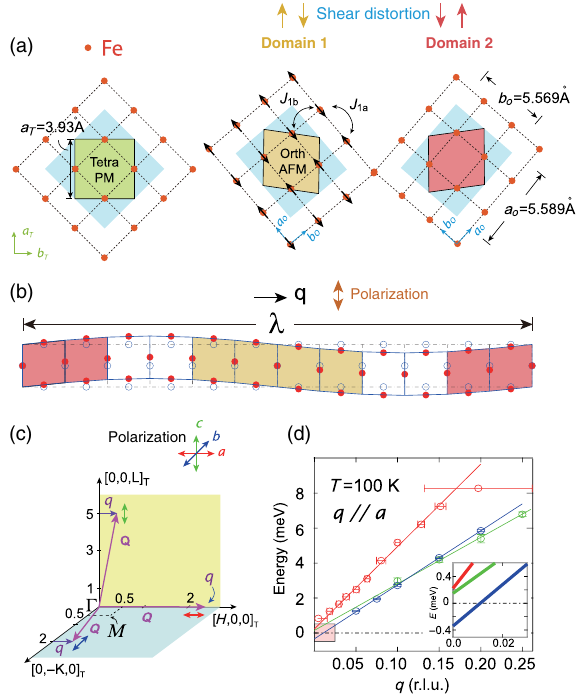
FIG. 1. (a) Left: Schematics of the Fe layers in NaFeAs. Red spots represent Fe atoms, and the tetragonal (orthorhombic) unit cell is shown by the green (blue) shaded square. The middle and right panels are the two orthorhombic domains. The yellow and red areas are the tetragonal unit cells with opposite shear distortions. The arrows in the middle panel indicate the spin direction in the AF ordered phase. The orthorhombic lattice parameters are a o ¼ 5 . 589 Å and b o ¼ 5 . 569 Å. (b) A particular IPTA phonon mode with a momentum propagating horizontally to the right but with Fe atoms oscillating vertically. Here, λ is the size of the probing domain, and it is inversely related to q . (c) The three different equivalent positions in reciprocal space used in our neutron scattering measurements in order to determine all three acoustic phonon branches. The purple arrows with q are the momentum of the measured phonons along the ½ H; 0 ; 0 (cid:2) direction, and the double-headed arrows represent the phonon polarizations along the a (red, LA), b (blue, IPTA), and c (green, OPTA) axes. (d) The corresponding dispersions of the three phonon modes at 100 K estimated from data in Ref. [37]. The inset shows an expanded view of the low-energy part of the dispersion.